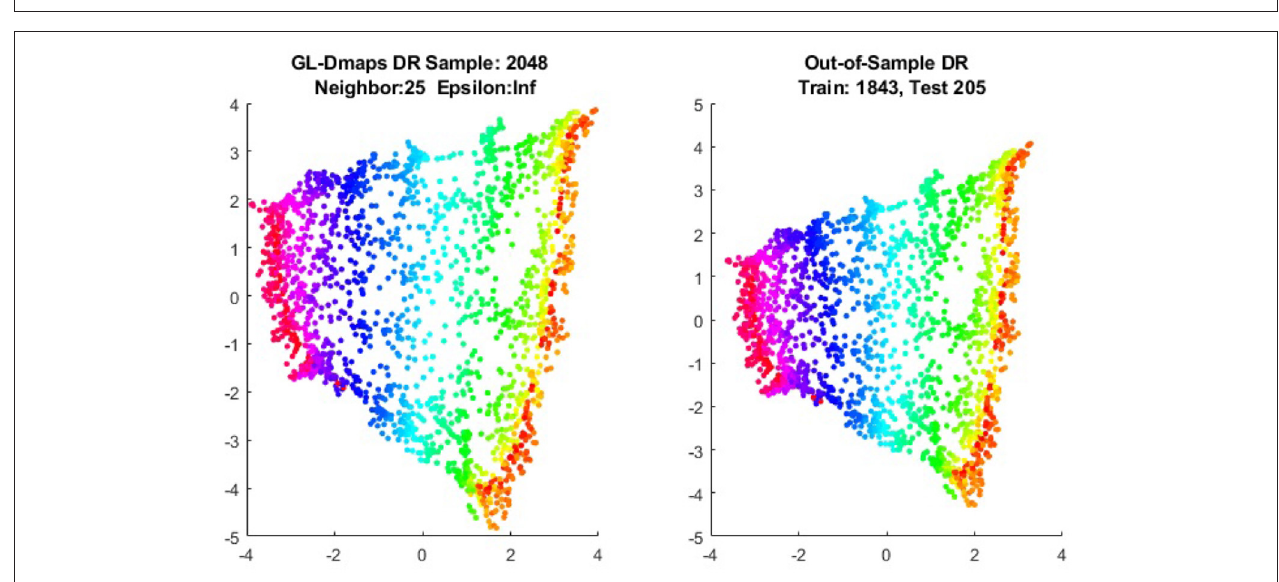
FIGURE 4 | GL out-of-sample extension for DR of 3D Cluster.